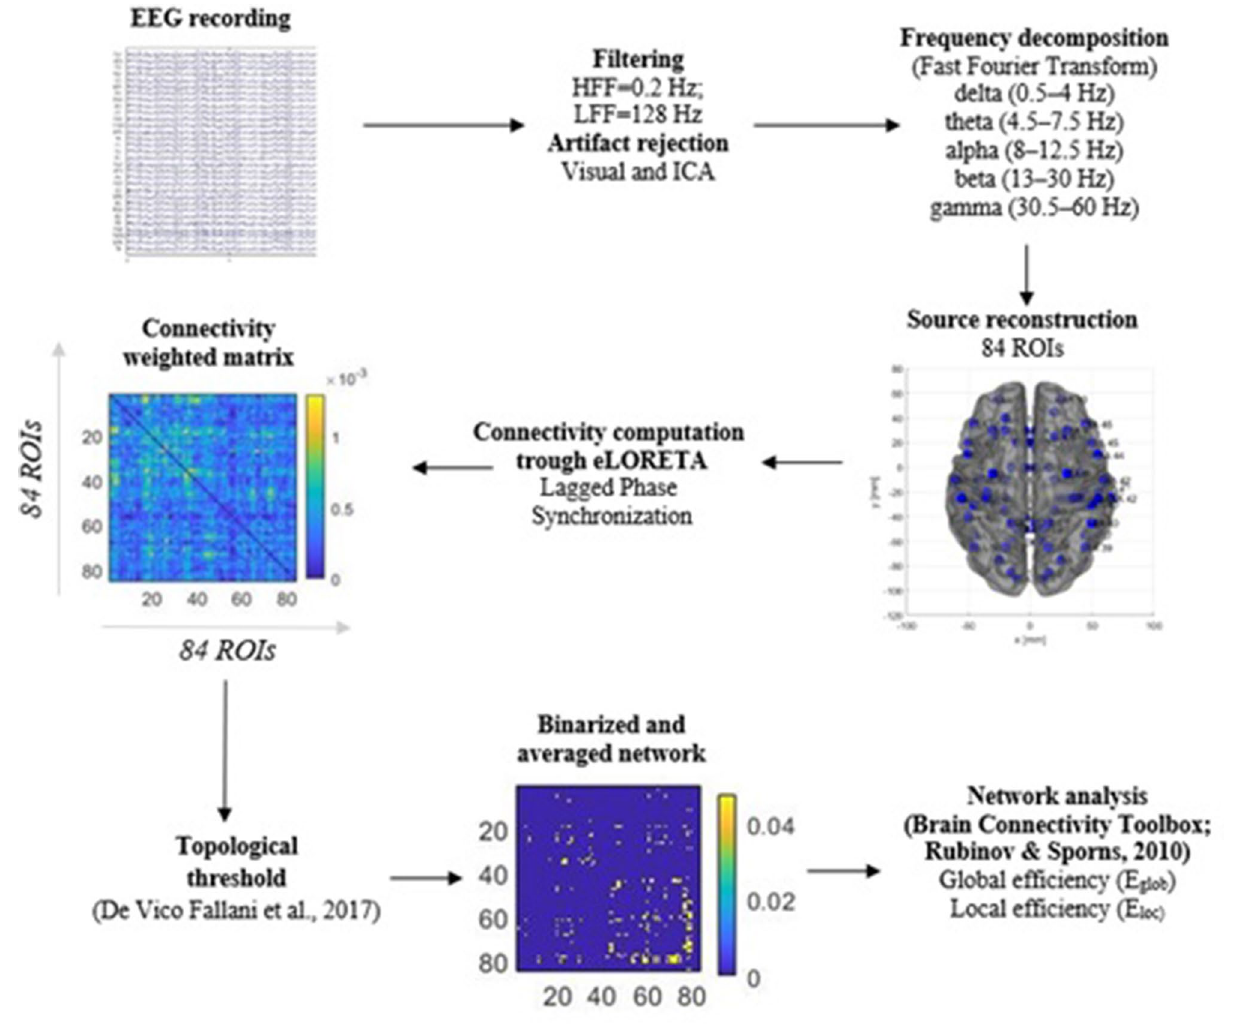
Figure 1. Overview of EEG recording, processing, and network analysis